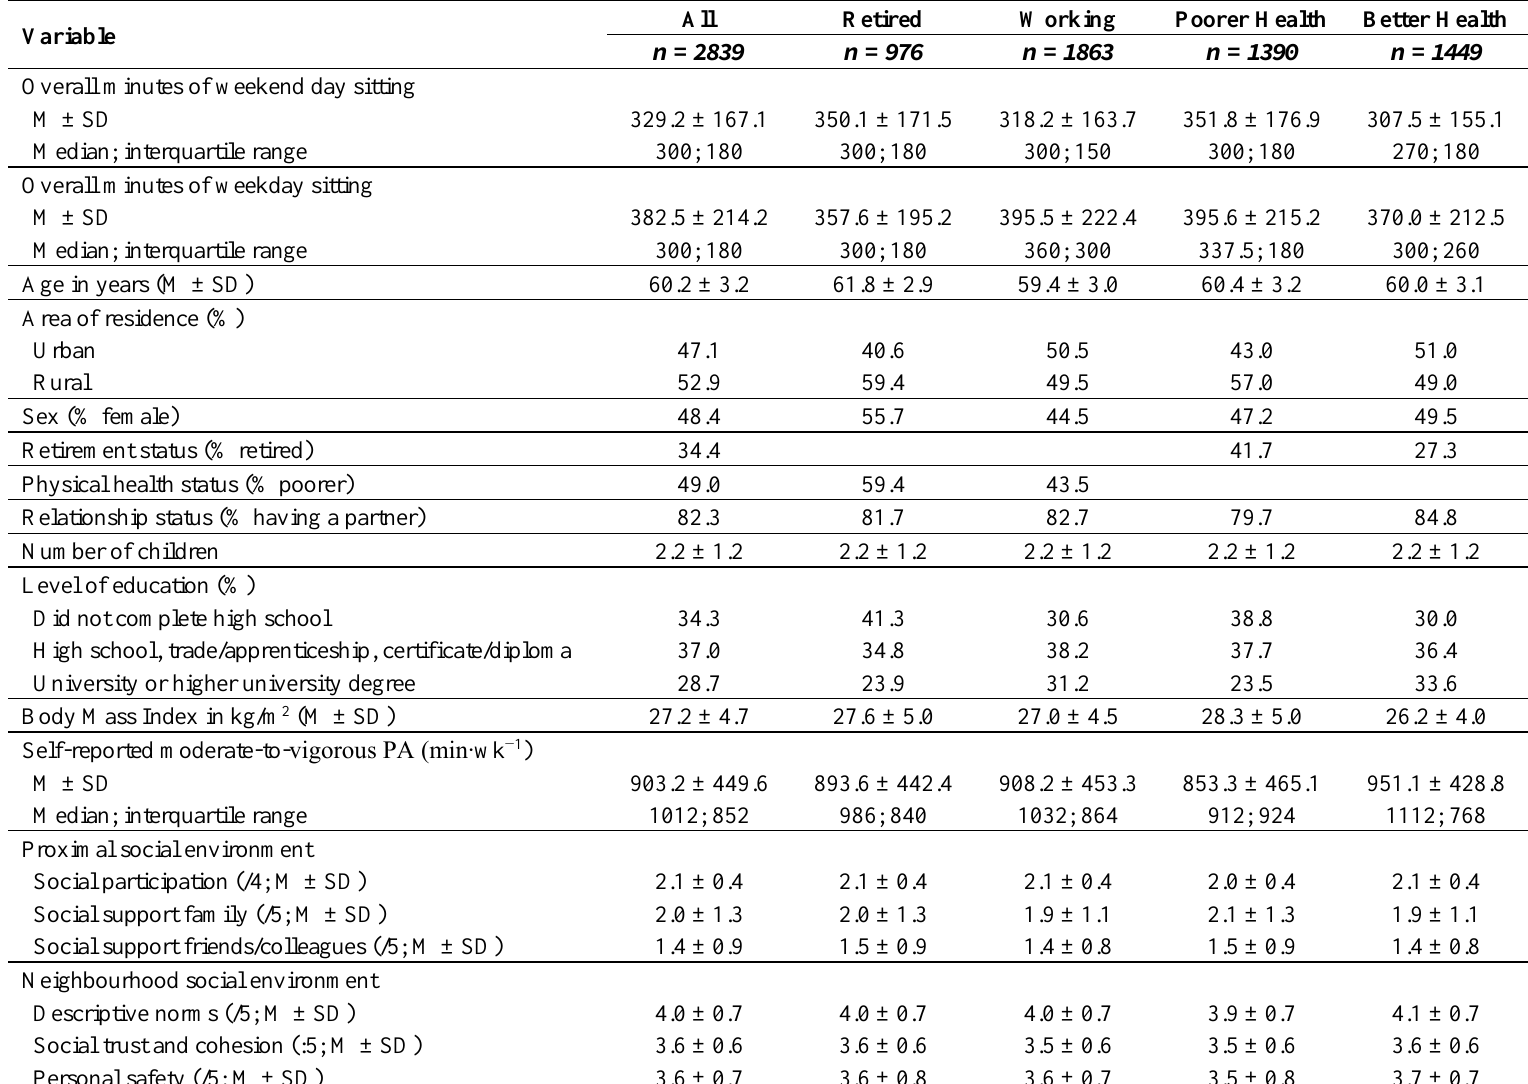
Table 1. Descriptive statistics of included